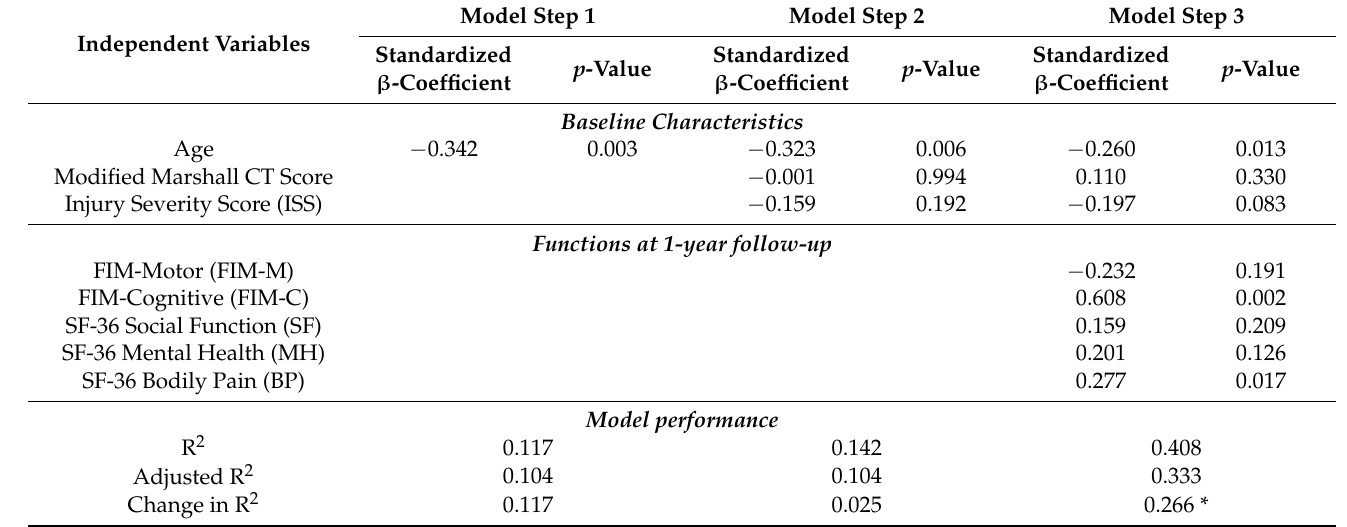
Table 2. Results of multivariable hierarchal linear regression: association between baseline character- istics, one-year functional measures and the community integration questionnaire measure at 10-year follow